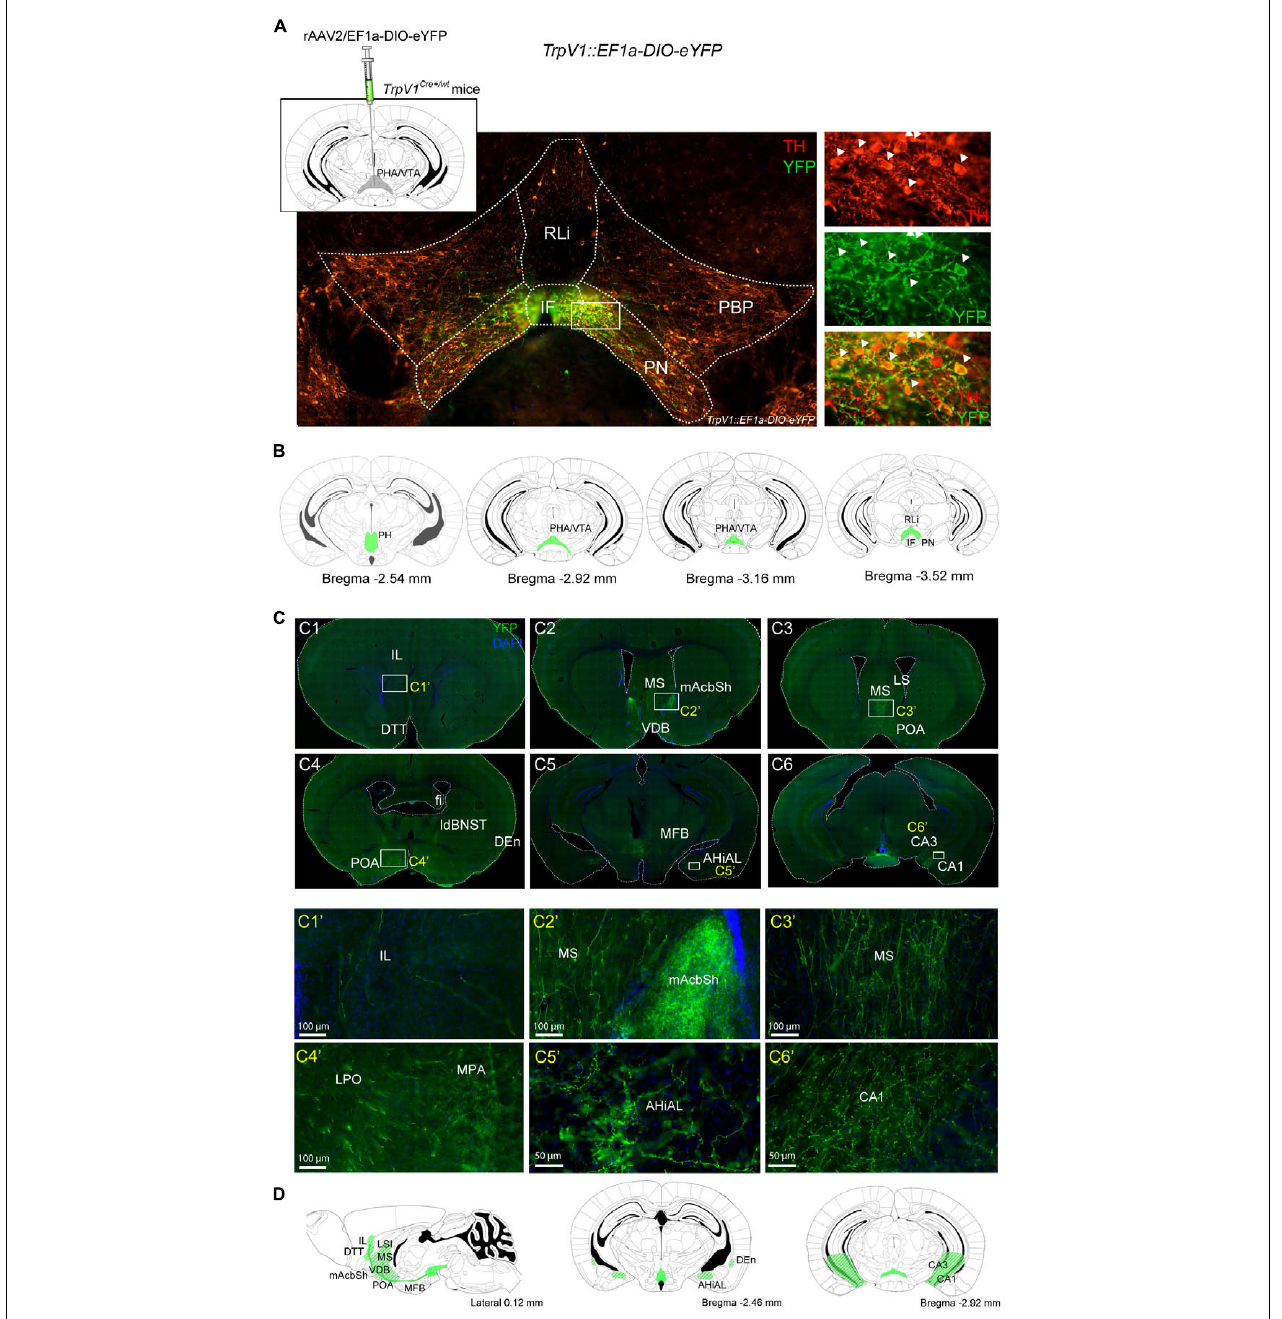
FIGURE 4 | Projections from TrpV1 + cells reach multiple forebrain target areas, including nucleus accumbens. (A) Top, left: Illustration of virus injection. TrpV1 Cre + / wt mice were unilaterally injected with the AAV-EF1a-DIO-eYFP virus to reach the TrpV1-positive area in the posterior hypothalamic nucleus (PHA) and ventral tegmental area (VTA). Bottom: Verification of injection in TrpV1::EF1a-DIO-eYFP mice (age postinjection, 13–18 weeks). YFP (green) and TH (red) immunofluorescence in coronal vibratome slice, double-positive cells detected primarily in IF and medial PN of the VTA, close-up in the right-side panel. (B) Illustration of coronal sections visualizing sites identified as positive for YFP-positive cell bodies (green fields) along the rostro-caudal axis. (C) YFP immunofluorescence in projections reaching various target areas, representative examples are shown. (C1’–C6’) Close up of areas shown in white squares in (C1–C6) . (D) Illustration-visualizing sites identified as positive for YFP-positive projections (green/white stripes in fields). Scale bars 100; 50 µ m. AHiAL, a lateral part of the amydalohippocampal area; CA1, field C1 of the hippocampus; CA3, field C3 of the hippocampus; DEn, dorsal endopirifom claustrum; DTT, dorsal tenia tegmental; fi, fimbria of the hippocampus; IF, interfascicular nucleus; ldBNST, a lateral dorsal part of the bed nucleus of the stria terminalis; LPO, lateral preoptic area; LS, lateral septum; MFB, medial forebrain bundle; mNAcSh, nucleus accumbens medial shell; MPA, medial preoptic area; MS, medial septum; PHA, posterior hypothalamic nucleus; PH, posterior hypothalamus; PN, paranigral nucleus of the ventral tegmental area; POA, preoptic areas; RLi, rostral linear nucleus; VDB, the nucleus of the vertical limb of the diagonal band.